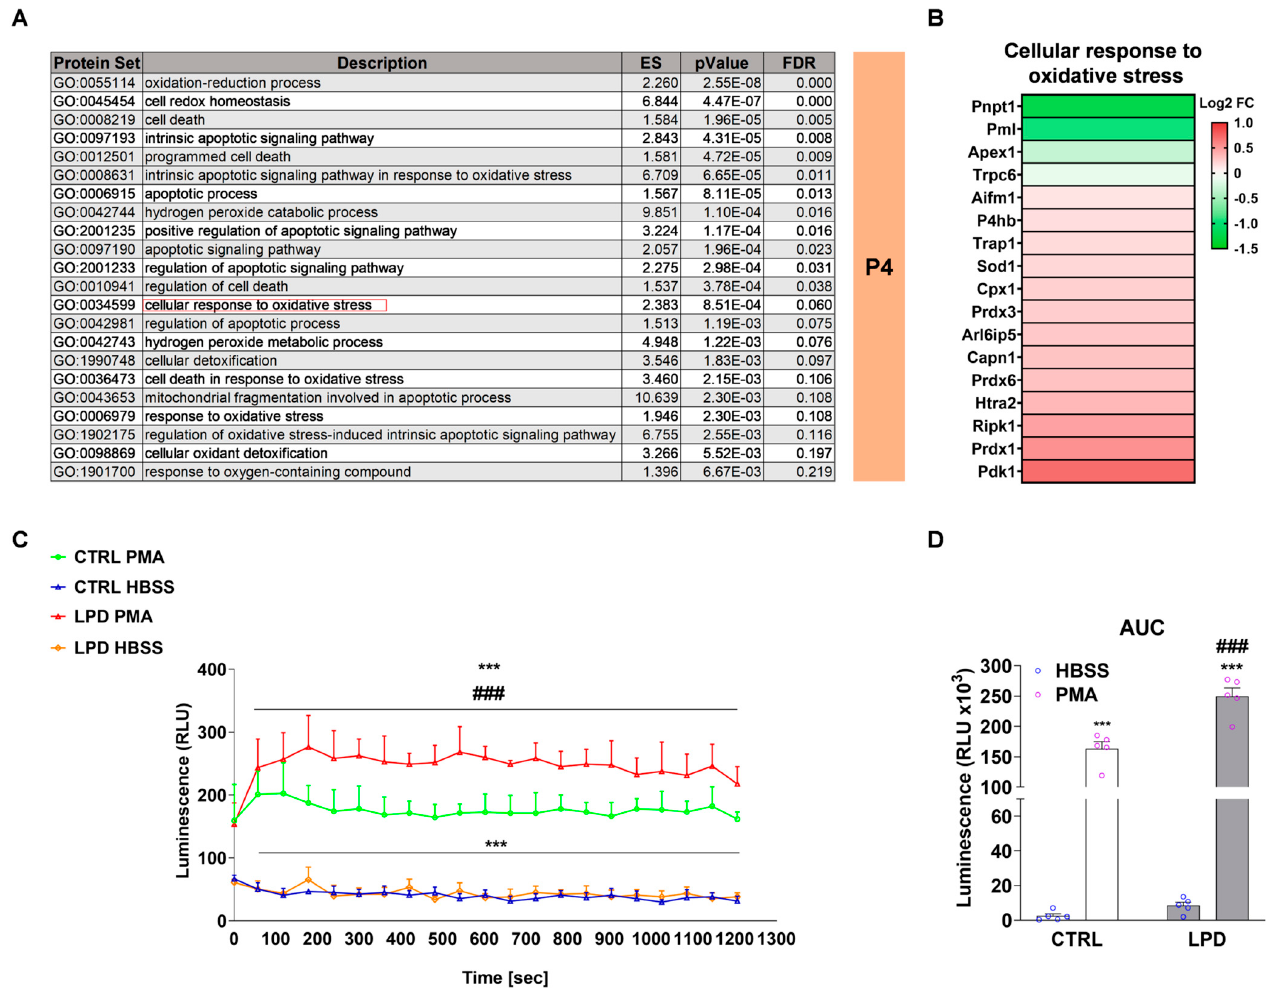
Figure 4. Protein sets associated with oxidative stress and cellular response to oxidative stress are enriched in the LPD microglial proteome. ( A ) ORA analysis of DE expressed proteins between CTRL and LPD at P4 performed against the GO database. ( B ) Log2 FC of proteins associated with the cellular response to oxidative stress. Upregulated proteins are depicted in red and downregulated proteins in green. ( C , D ) ROS assay: ( C ) Relative light unit (RLU) values and the ( D ) area under the curve (AUC) corresponding to the total RLU signal measured over 20 min are reported. Data (Mean ± SEM), *** p < 0.001 vs. respective HBSS, ### p < 0.001 vs. CTRL.